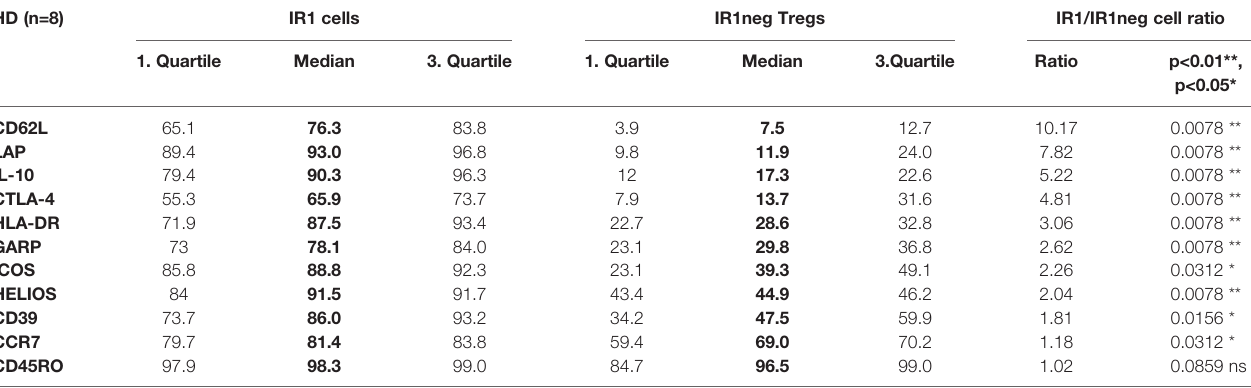
TABLE 3 | Median and inter-quartile ranges (IQR) of percent marker expression on IR1 and IR1neg Tregs after 72h in vitro IL-2 exposure of PBMC. HD (n=8) IR1